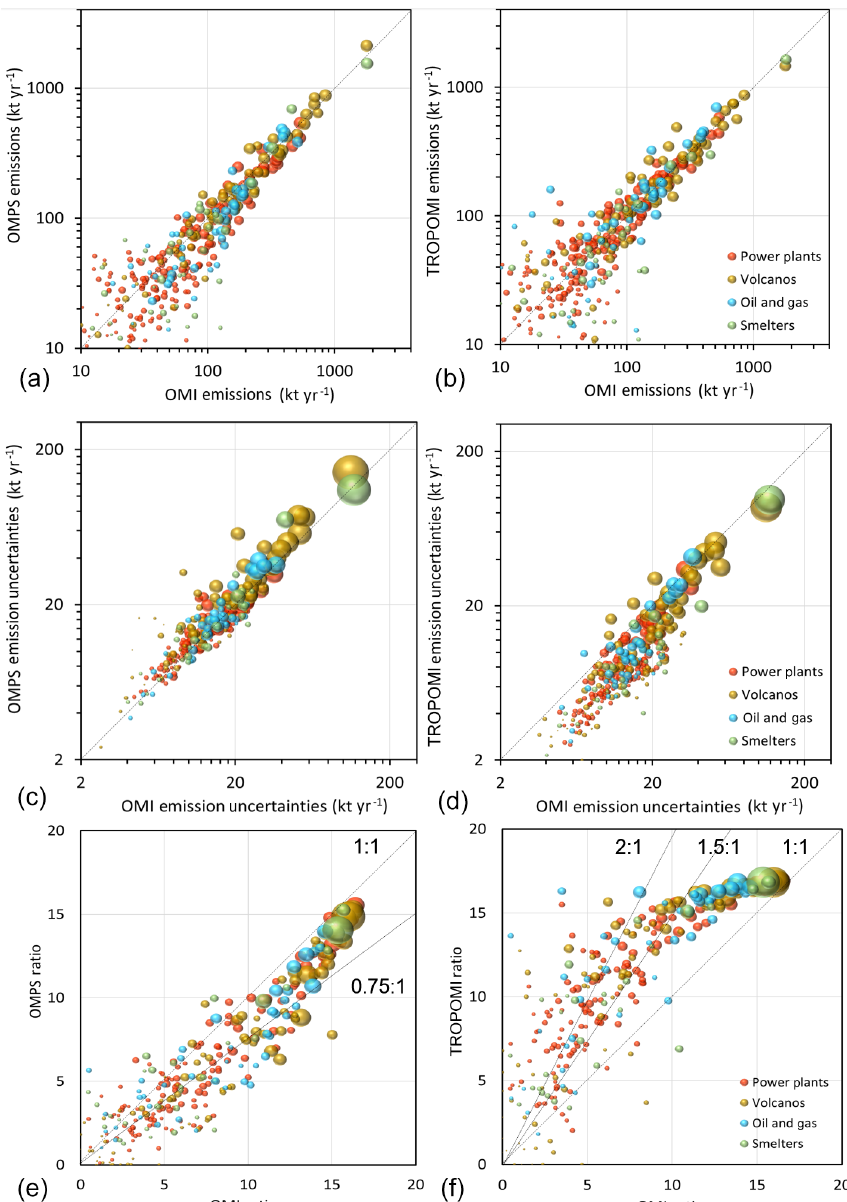
Figure 10. (a) Estimated OMI-, OMPS-, and TROPOMI-based emissions in kilotons per year. The bubble area is proportional to the ratio of emission to uncertainty. The bigger the bubble, the more reliable the estimate. (b) Emission uncertainties in kilotons per year. The bubble area is proportional to the emission rate. The bigger the bubble, the higher the emissions. (c) Ratios between estimated emissions and their uncertainties. The bubble area is proportional to the emission